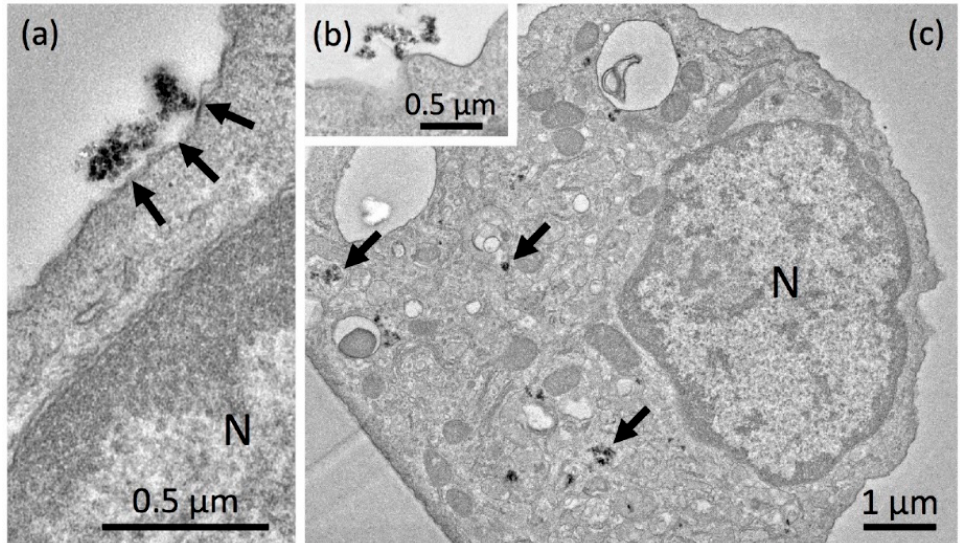
Figure 4. Detection of precipitated P-5 silica nanoparticles in NR8383 cells by transmission electron microscopic (TEM). Cell were treated with 17 µg P-5 per mL in serum-free F-12K and fixed after 90 min. ( a ) P-5 aggregate/agglomerate attached to the cell; the underlying cell membrane appears intact. ( b ) P-5 aggregate/agglomerate close to the site of endosome formation. ( c ) NR8383 macrophage filled with numerous P-5-laden lysosomes and phagolysosomes (arrows).